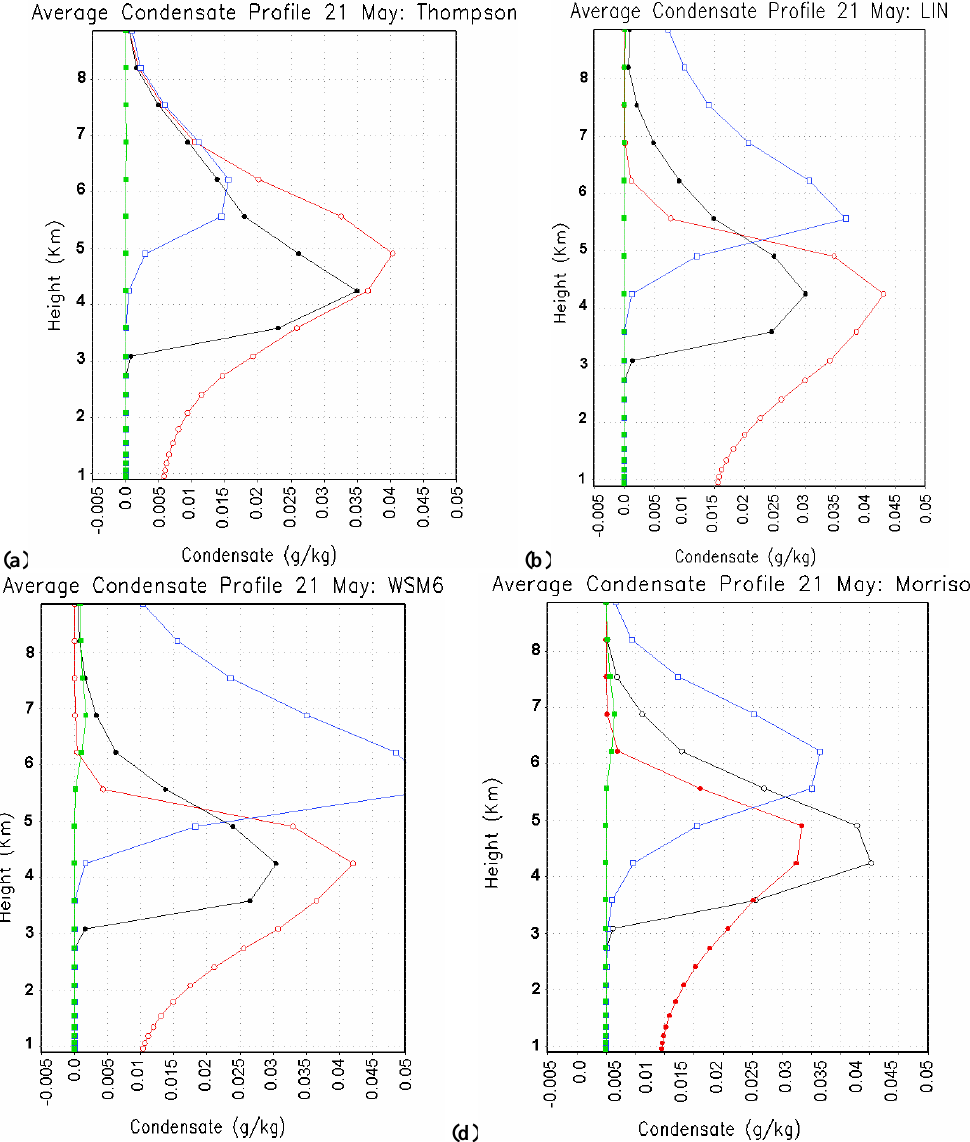
Fig. 12. Vertical profiles of cloud condensate (Cloud water (red), rain water (black), cloud Graupel (Blue) and Cloud Ice (Green)) in gKg − 1 simulated by the model with four different MP schemes (a) Thompson, (b) Lin, (c) WSM6, and (d)